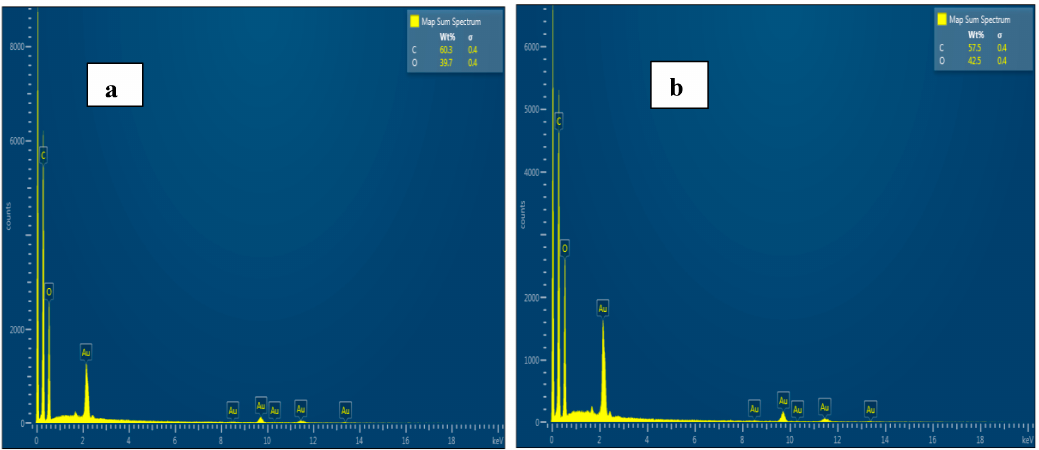
Figure 6. SEM image of ( a ) longitudinal outer surface of neat CA fiber ( b ) longitudinal outer surface of CA-MWCNT 0.5 wt. % fiber ( c ) cross-sectional view of neat CA fiber ( d ) cross-sectional view of CA-MWCNT 0.5 wt. % fiber.